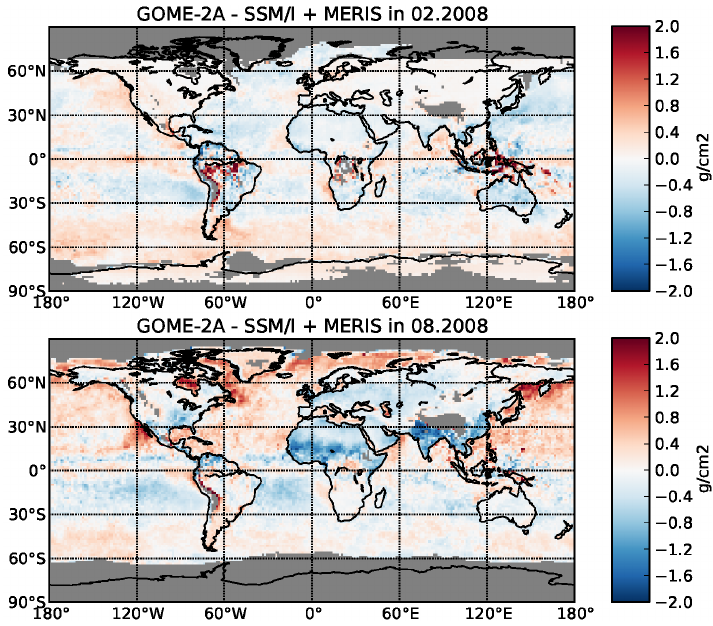
Figure 13. Geographical distribution of the differences between GOME-2A and the combined SSM/I + MERIS total column water vapour data set in February 2008 (top panel) and August 2008 (bottom panel). Only cloud-screened co-located data have been